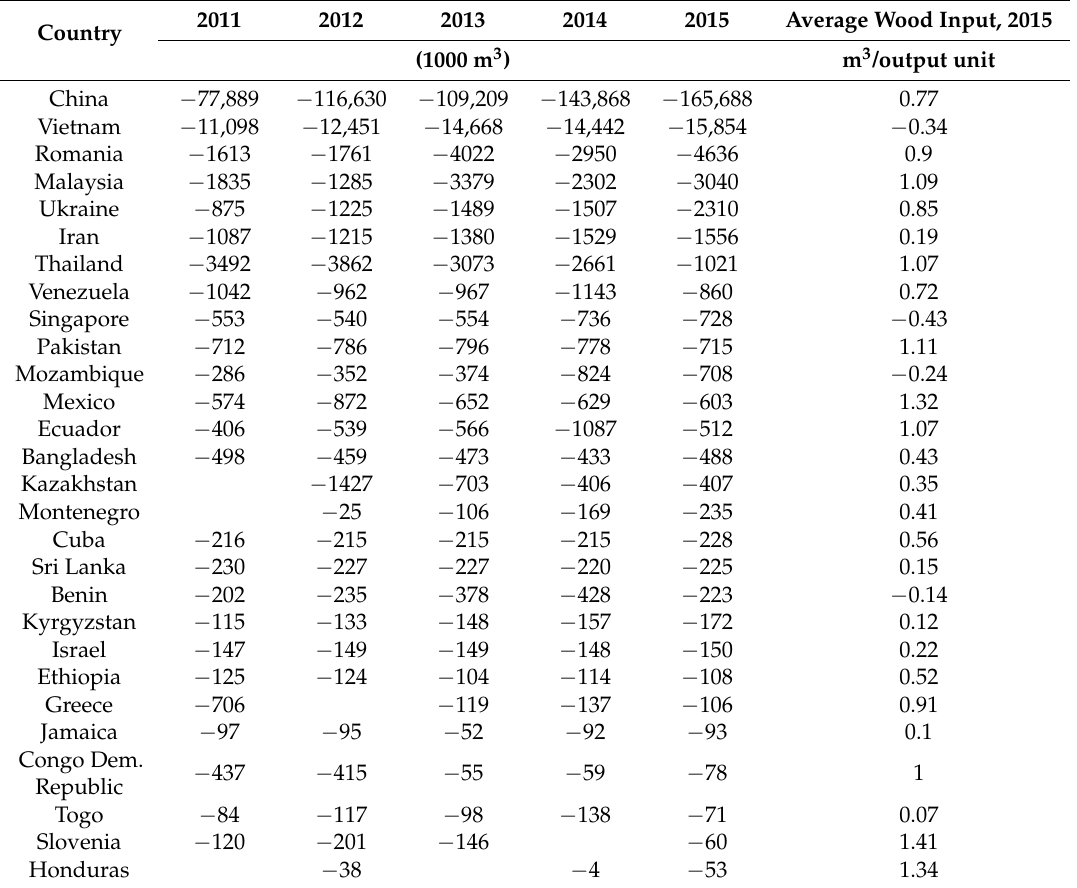
Table 6. Results from test iii for all wood. a deficit of wood is defined as “domestic production or harvests of wood + imports – exports – wood input needed in the forest industry” during 2011–2015, and the maximum wood input coefficient in forest industry production is defined as “(amount of wood available)/(production of pulp and mechanical forest industry products)”. Only countries with a deficit of wood exceeding 50,000 m 3 in 2015 are shown. Only negative entries are